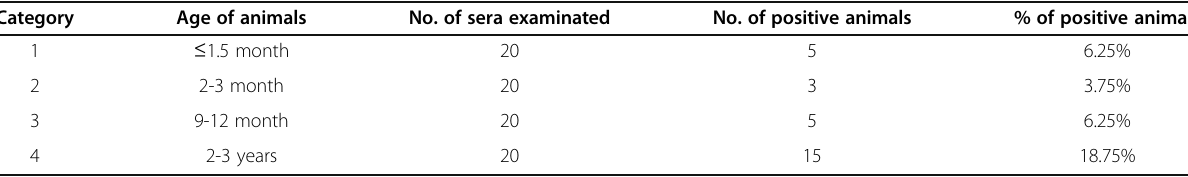
Table 2 Percentages of Mcc-positive goats Category Age of animals No. of sera